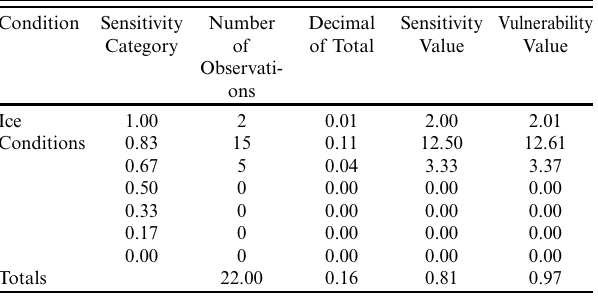
Table 2 . Example of how final vulnerability value was calculated for a single condition (ice conditions) documented by a single harvester during the 12-month GPS data collection